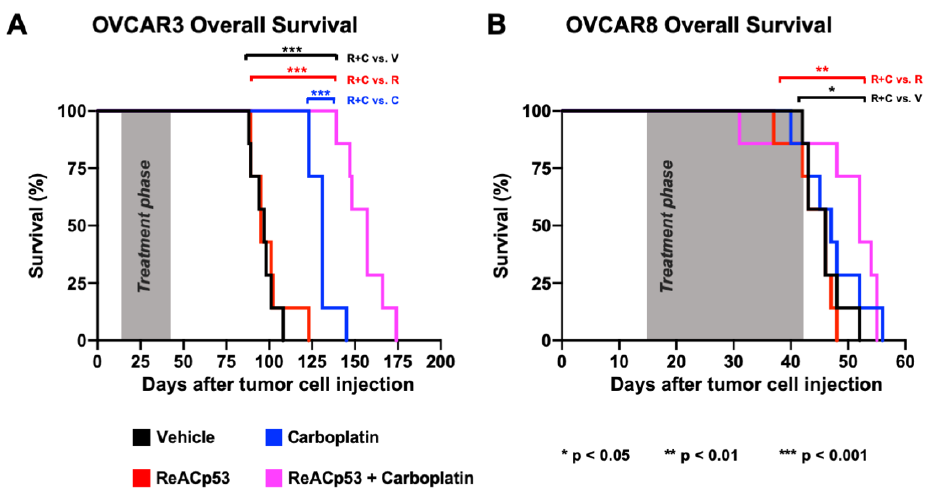
Figure 4. ReACp53 to carboplatin combination extended overall survival of mice bearing OVCAR3 but not OVCAR8 ovarian cancer xenografts. Xenografts were established by injecting either 3.0 × 10 6 OVCAR3 or OVCAR8 cells into the intraperitoneal (IP) space of NSG mice (n = 29 mice/cell line). We confirmed tumor take by euthanizing n = 1 mouse/cell line prior to initiating treatment. The remaining n = 28 mice/cell line were randomized to receive either vehicle, ReACp53 15 mg/kg 3×/week IP, carboplatin (10 mg/kg for OVCAR3 tumors, 50 mg/kg for OVCAR8 tumors) 1×/week IP, or ReACp53 and carboplatin combination therapy (n = 7/treatment). Following four weeks of treatment, mice were released off-therapy and monitored daily for signs of distress. Upon reaching NIH-endpoint criteria, mice were euthanized, and the total time from tumor cell injection to endpoint was recorded for each animal. These data were used to generate Kaplan–Meier curves for overall survival. ( A ) OVCAR3 tumor-bearing mice treated with ReACp53 and carboplatin combination therapy had a longer median survival (157 days) compared to vehicle (97 days, p < 0.001), ReACp53 (95 days, p < 0.001), or carboplatin (131 days, p < 0.001). ( B ) OVCAR8 tumor-bearing mice treated with ReACp53 and carboplatin combination therapy had a median survival of 52 days compared to vehicle (46 days, p < 0.05), ReACp53 (46 days, p < 0.01), or carboplatin (47 days, p = 0.46). * p < 0.05, ** p < 0.01, *** p < 0.001.